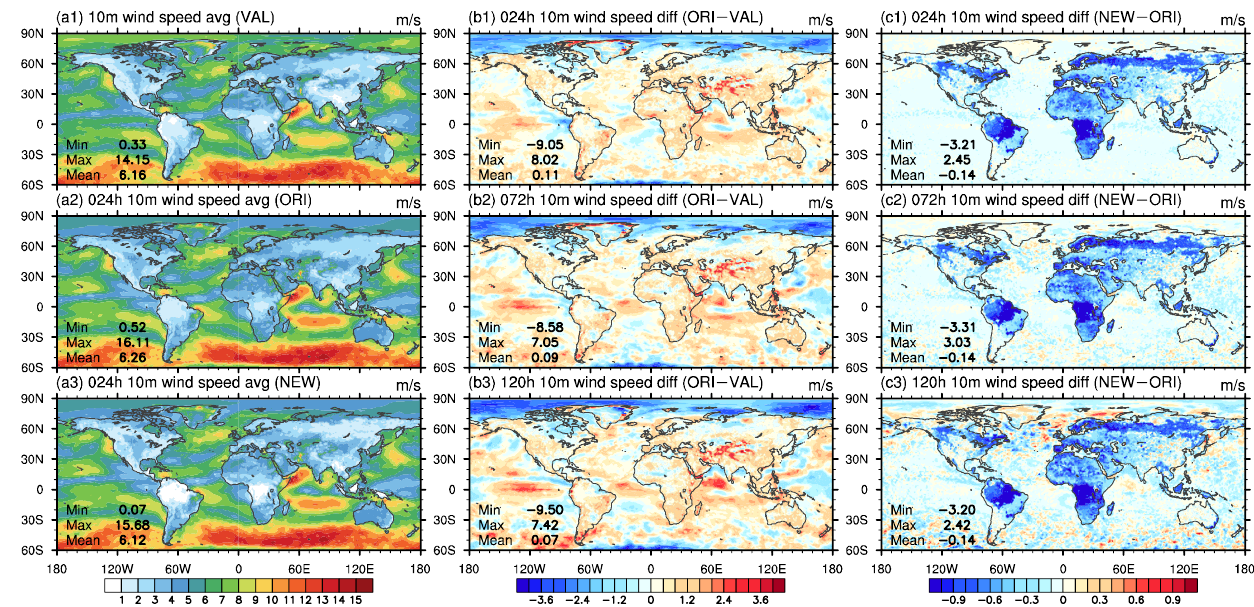
Figure 4. Same as Figure 2, but for wind speed at 10 m (units: m · s − 1 ).